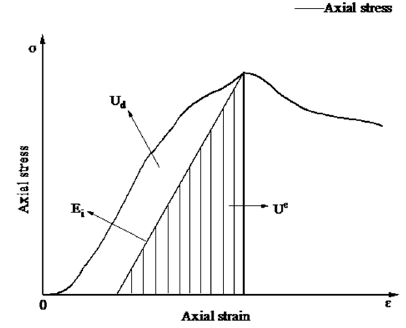
Figure 8. The energy relationship between 𝑈 (cid:3031) and 𝑈 (cid:3032) per unit volume of rock. Using Equations (6)–(8), the total strain energy U, dissipative energy 𝑈 (cid:3031) , and releas- able elastic strain energy 𝑈 (cid:3032) corresponding to the peak points of the di ff erent water con- tent rates can be obtained as shown in Table 7. The ratio of the releasable elastic strain energy and the dissipated energy to the total input strain energy of each test piece is then plo tt ed as shown in Figure 9. Table 7. The strain energy corresponding to the peak point of each specimen. Total Input Strain Releases Elasticity Specimen Number Energy 𝐔 Strain Energy 𝑼 𝒆